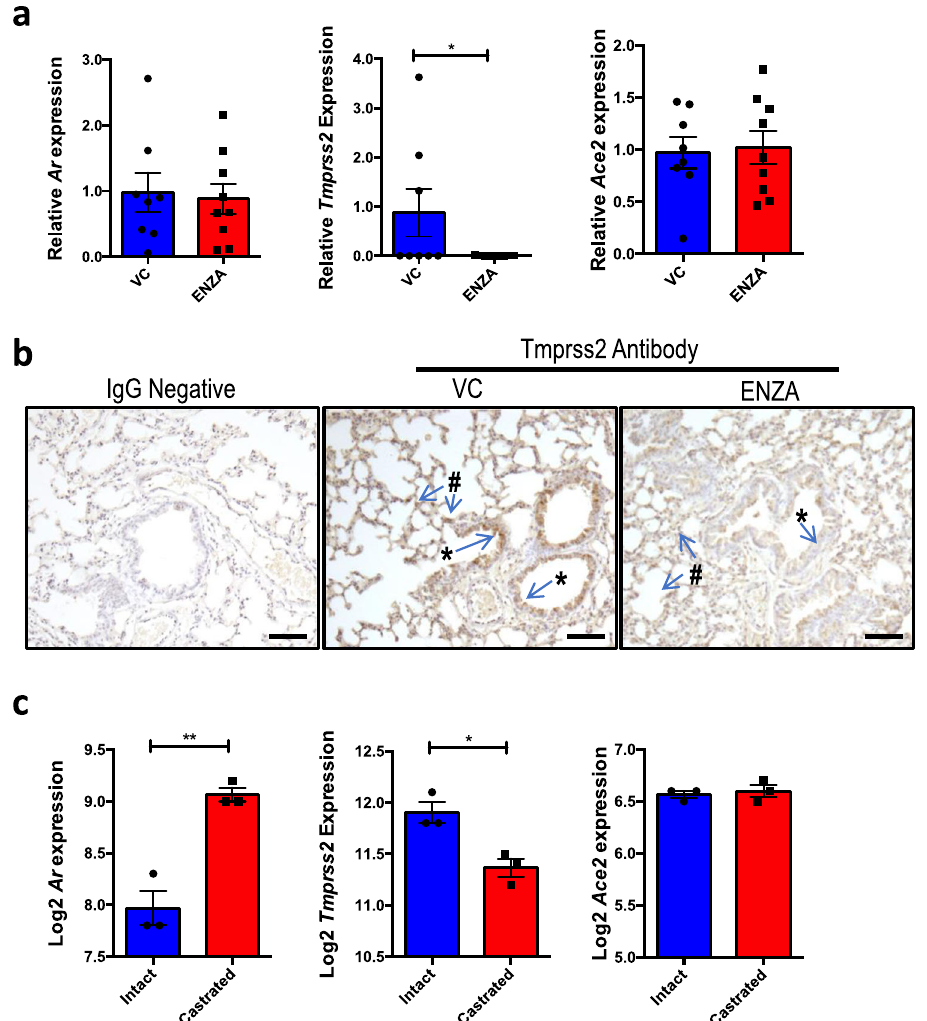
Fig. 5 Enzalutamide downregulates Tmprss2 in mouse lung. a Relative expression of Ar , Tmprss2 and Ace2 mRNA from lung tissue of mice treated with enzalutamide (ENZA, n = 9) or vehicle control (VC, n = 8) once daily for 3 days. Expression was normalised to housekeeping genes and made relative to VC. Mean ± 1 SE. Student ’ s t -test (one-tailed) * p = 0.0367. b Example of Tmprss2 IHC in mouse lung. Representative immunostaining of epithelial cells (*) and parenchyma/AT cells (#) in sections from n = 9 VC-treated mice, and n = 8 ENZA-treated mice. Bar = 50 μ m c Log2 expression of Tmprss2 , Ar and Ace2 in lung tissue from male mice physically castrated ( N = 3) vs intact male mice ( N = 3) (GSE31341) 50 . Mean ± 1 SE. Student ’ s t -test (one-tailed), ** p = 0.0018, * p = 0.0081. Source data are provided as a Source Data